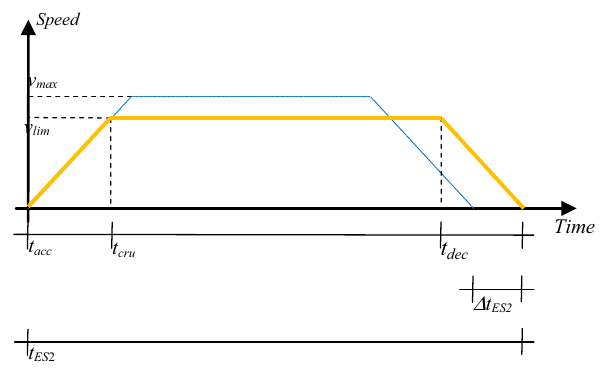
Fig. 16 Speed profile in the case of energy-saving (ES)